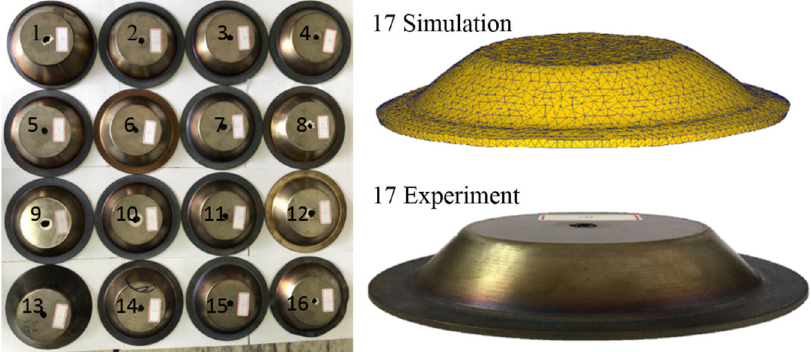
Figure 12. Experiment and simulation parts.